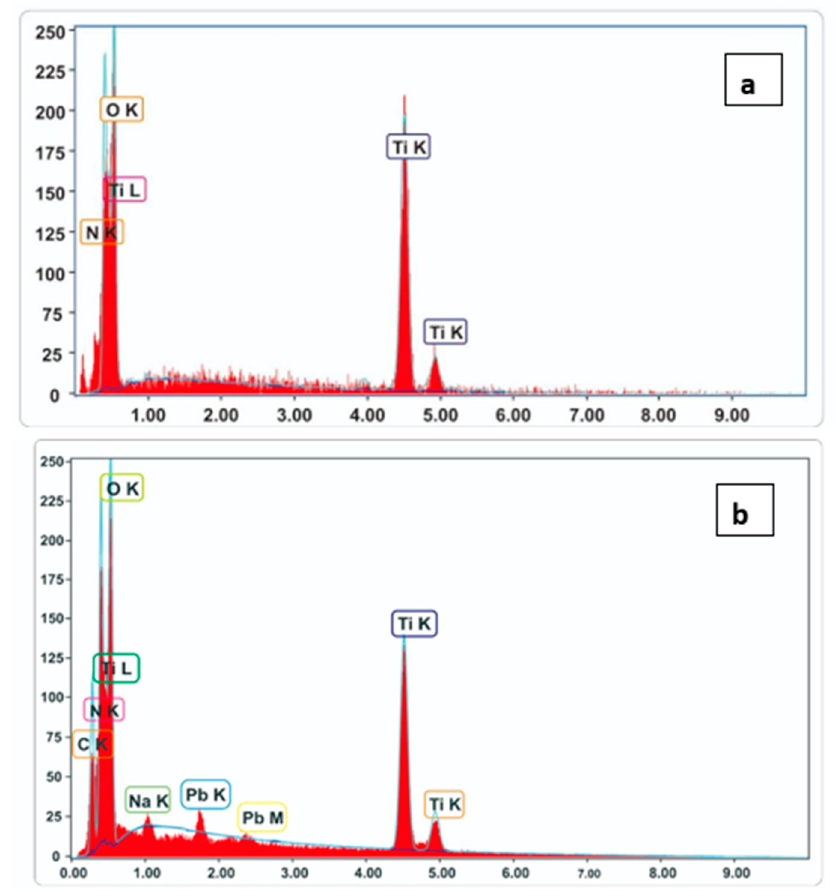
Figure 10. The EDX spectra of ( a ) TiO 2 –N (10) before and ( b ) TiO 2 –N (10) after used for Pb(II) photo- oxidation .